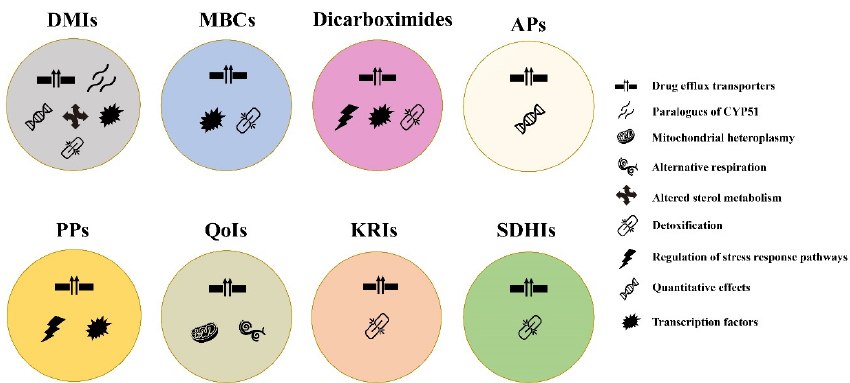
Figure 2. Non-target site mechanisms of resistance to major classes of fungicides used for crop disease management. Each circle with different colors represents a chemical class, whereas symbols within circles each represent a resistance mechanism as shown in the figure. DMIs: Demethylation inhibitors; MBCs: Methyl benzimidazole carbamates; APs: Anilino-pyrimidines; PPs: Phenylpyrroles; QoIs: Quinone outside inhibitors; KRIs: Ketoreductase inhibitors; SDHIs: Succinate dehydrogenase inhibitors.